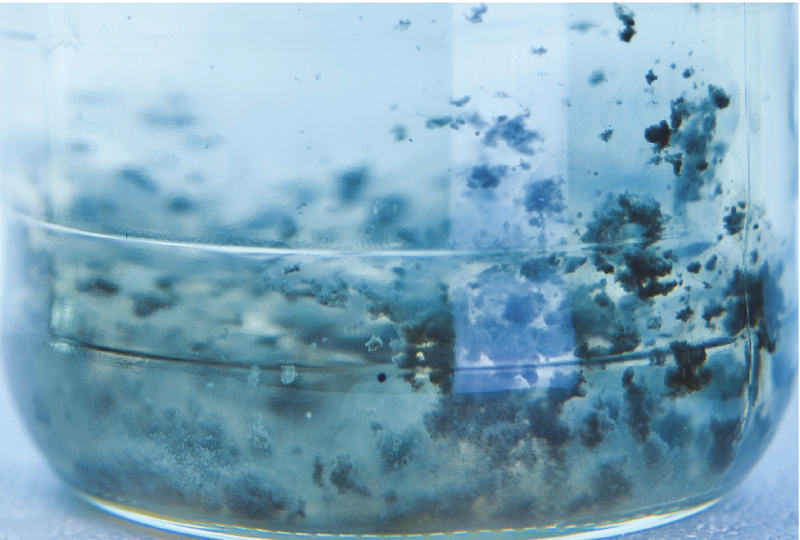
Fig 1. Methane production and growth of Tepidanaerobacter acetatoxydans and Methanoculleus spec. MAB2. A triplicate of co-cultures consisting of SAOB and the methanogenic partner Methanoculleus spec. MAB2 were cultivated on 100 mM acetate and SAO activity was followed by methane production, as described in the “ Material and methods ” section. Growth was monitored by quantification of the 16S rRNA gene by PCR in one of the cultures as described in the same section (The values obtained for T . acetatoxydans were divided by two). White square: T . acetatoxydans ; white diamond: Methanoculleus